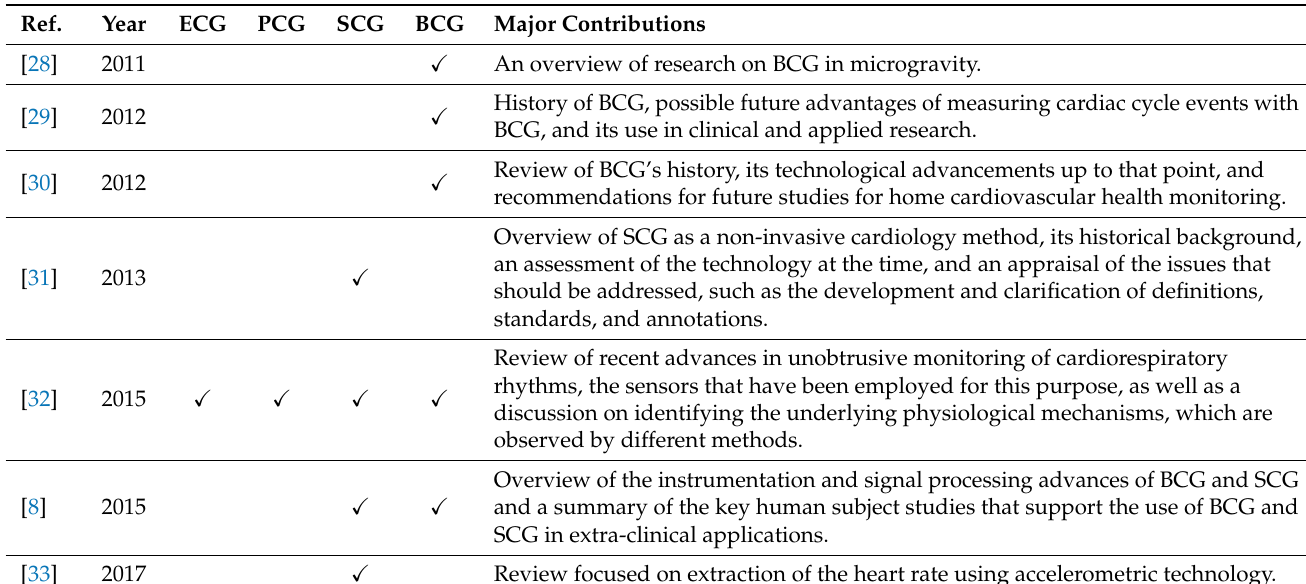
Table 1. Comparison of existing reviews in the